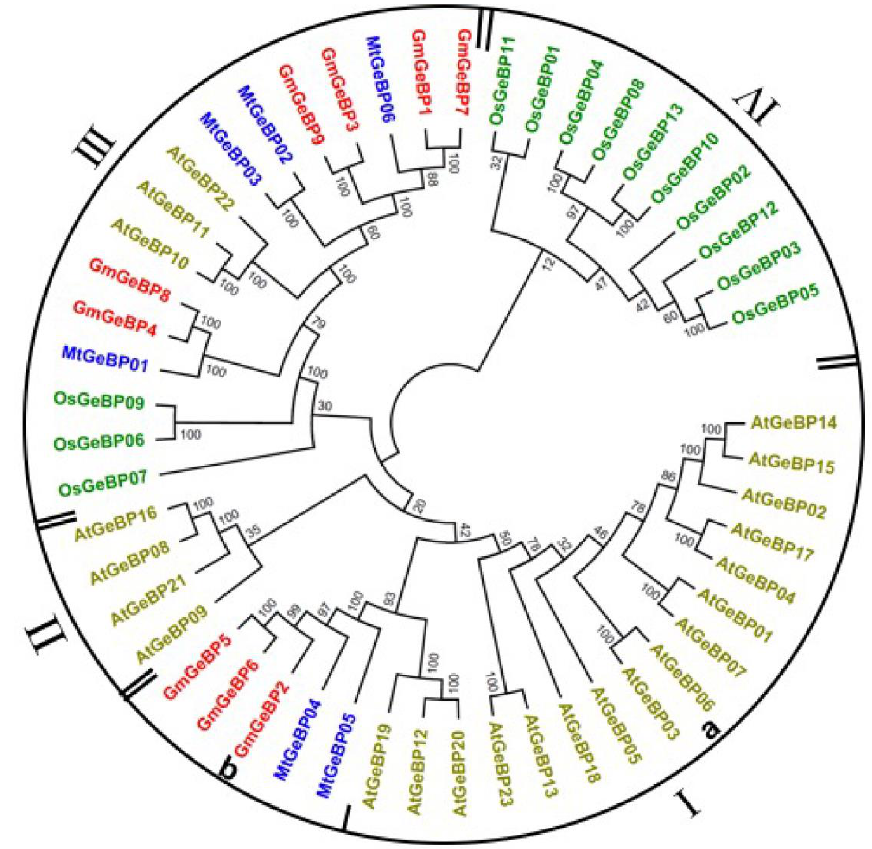
Figure 2. The phylogenetic tree of GeBP proteins from soybean and other plants, including Arabidopsis thaliana, O. sativa and Medicago sativa L. The phylogenetic tree was constructed using MEGA version 11.0 with the neighbor-joining (NJ) method. The members of each GeBP gene family are indicated with the same color.